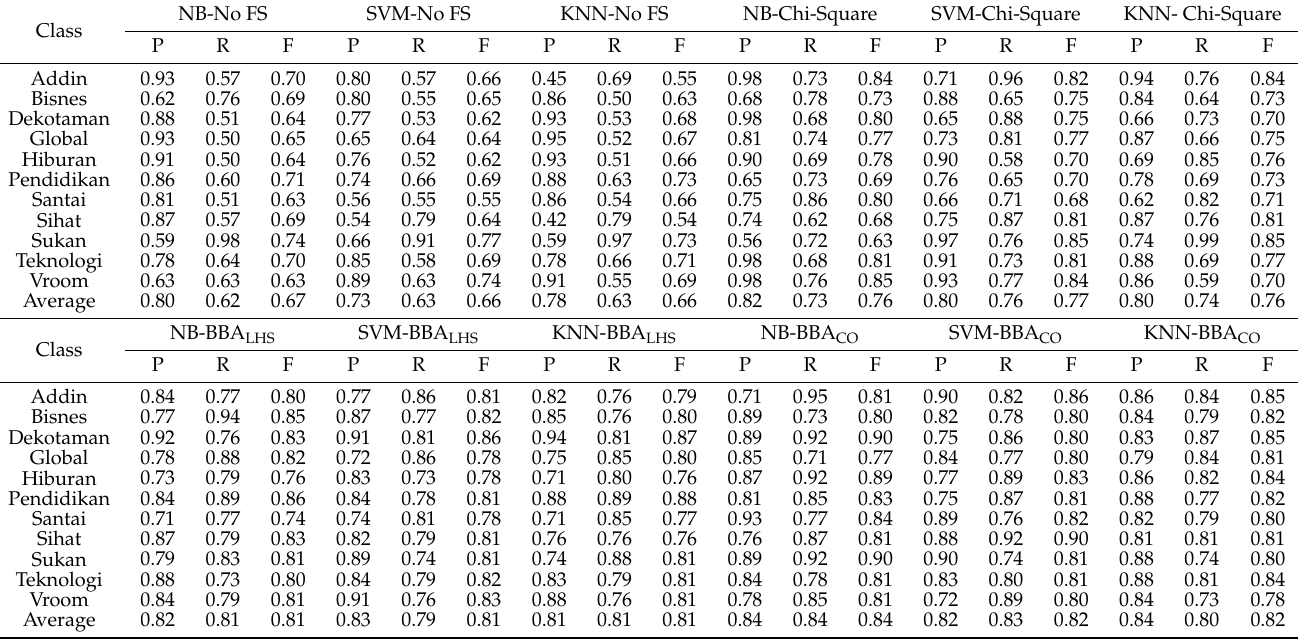
Table 20. Classification results of Harian Metro dataset using NB, SVM and KNN classifiers in terms of precision (P), recall (R) and F-measure